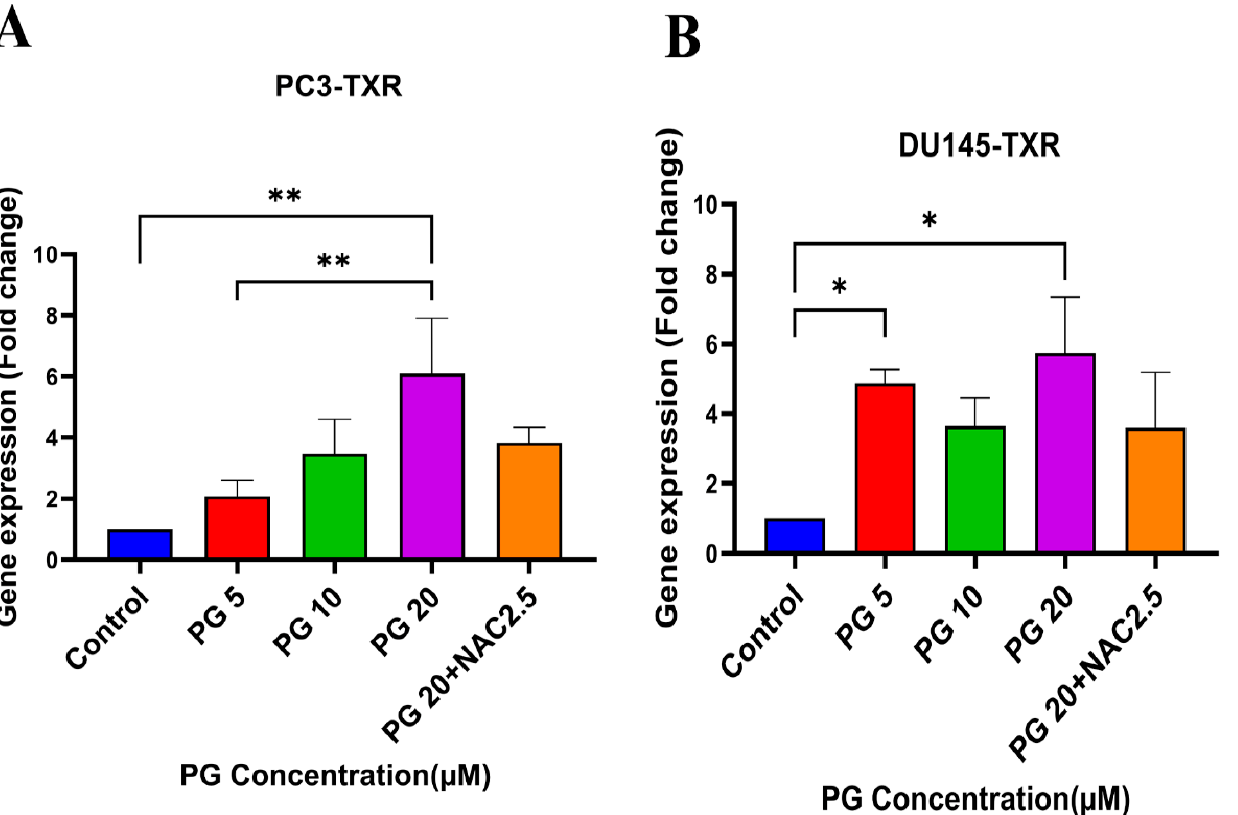
Figure 8. PG promotes anoikis in taxane-resistant PCa cell lines via the activation of PTEN. ( A ) PC3- TXR and ( B ) DU145-TXR cell lines. Our data illustrate that PG induces upregulation in the expression of PTEN . Data are represented as mean ± SD ( n = 3), and a total of three experiments were performed independently in triplicate. * p < 0.05, ** p < 0.01.